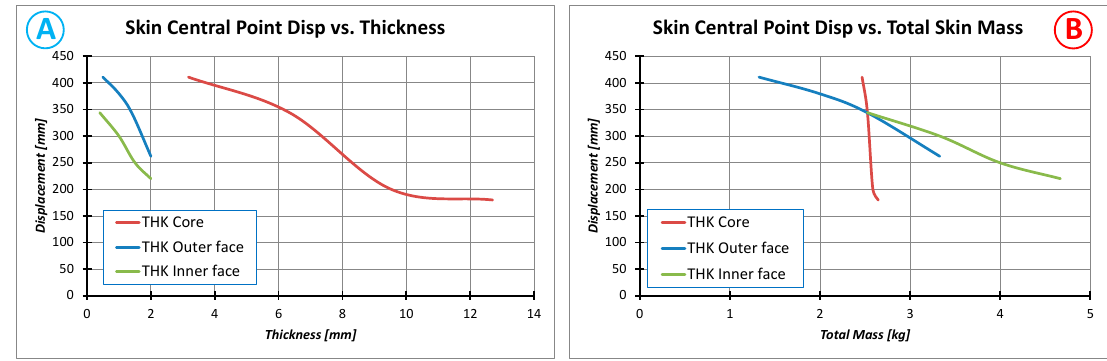
Figure 8. Sensitivity analysis results. ( A ) Apex displacement vs. thickness; ( B ) Apex displacement vs. mass.